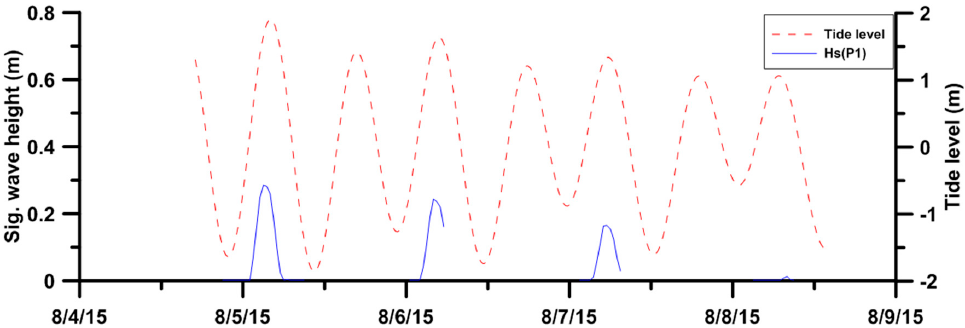
Figure 4. Significant wave heights and predicted tide elevations off Mumbai from 5–8 August 2015.